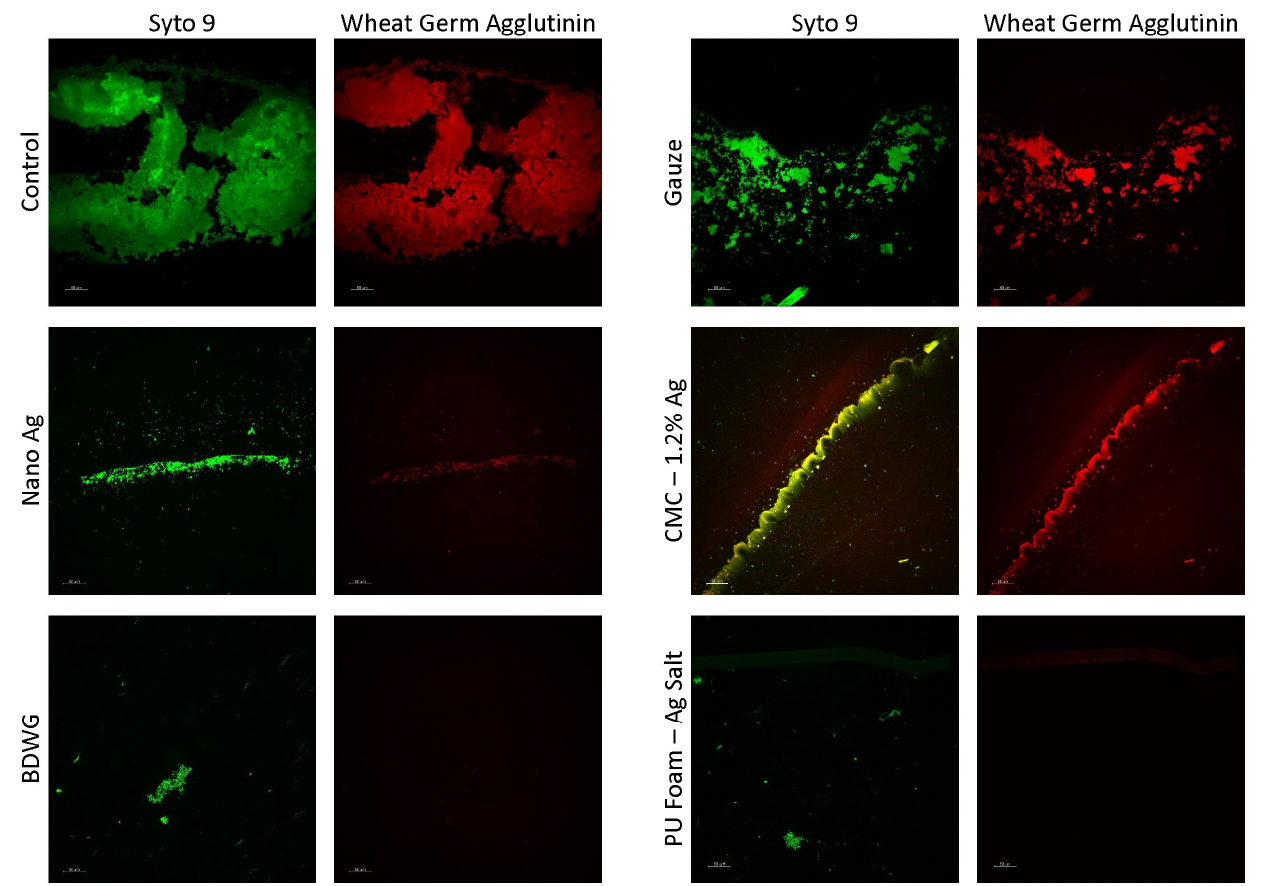
Figure 4. CSLM images of cryosections from membrane/dressing pairs after the 24 h treatment period stained with SYTO™ 9 and Texas Red ® conjugated Wheat Germ Agglutinin